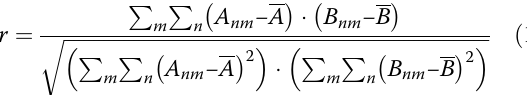
The algorithm for template matching correlates the resized segmented character with the ten template